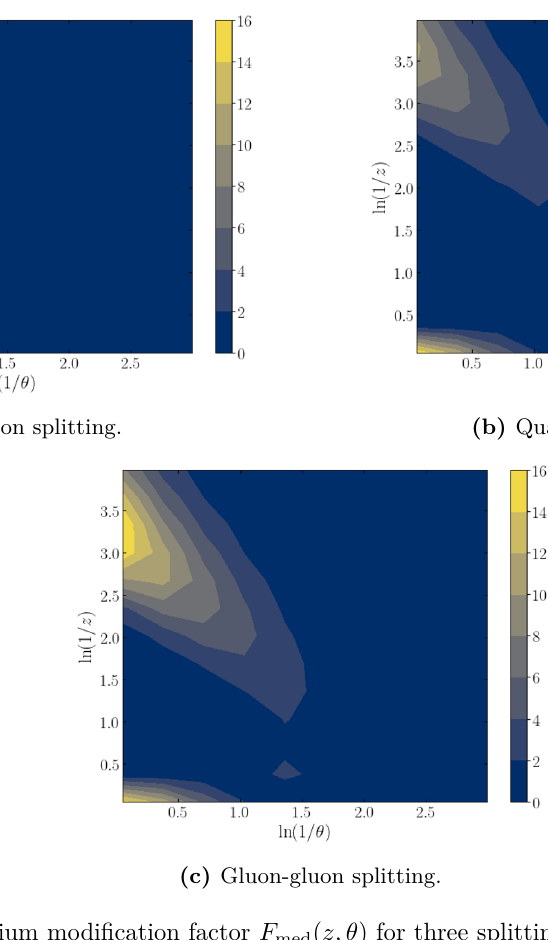
Figure 3. The medium modification factor F med ( z, θ ) for three splitting processes as a function of θ and z with L = 2 fm and E = 100 GeV at finite N c